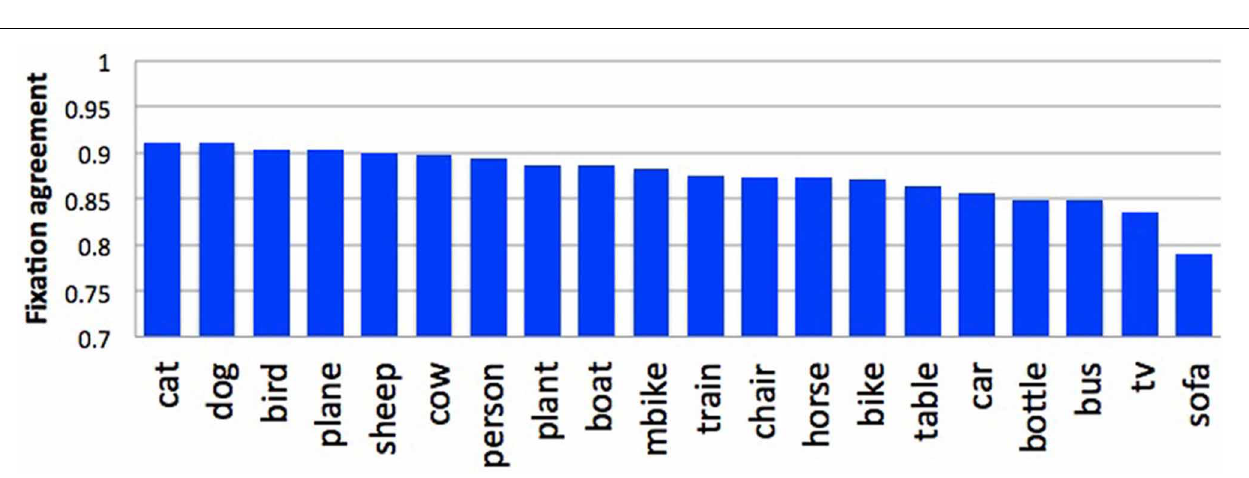
FIGURE 8 | Fixation agreement by object type for the Pascal